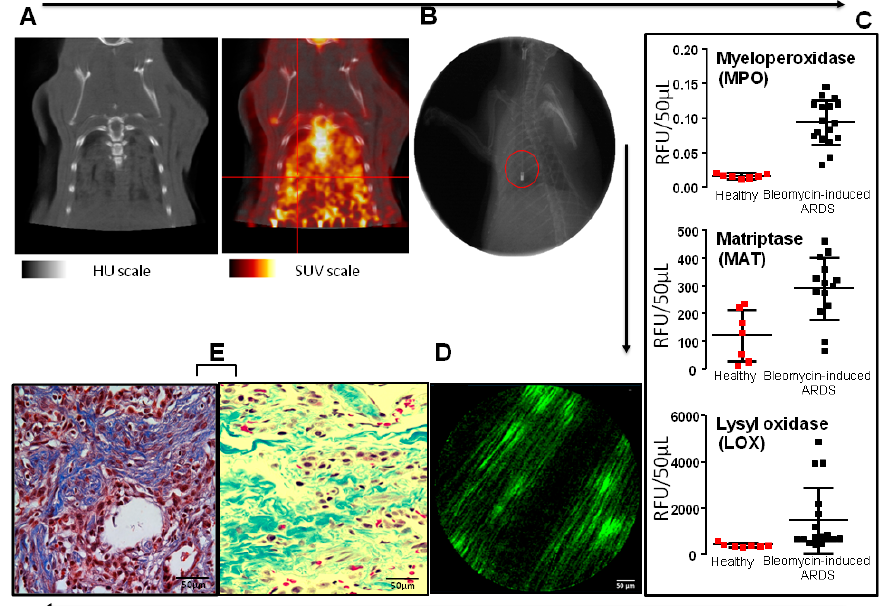
Figure 5. Proposed multimodality testing / imaging sequence in ARDS with unconventional timescale for recovery. Example of a preclinical approach with an experimental model of bleomycin lung in rat. ( A ) Acute lung injury with bilateral infiltrates is documented by PET–CT (respective scales: PET: 0 to 1.84 standardized uptake value (SUV); CT: − 1000 to + 2000 Hounsfield Units (HU)). Diffuse and enhanced uptake of fluoro-deoxyglucose (FDG) is documented allowing for the selection of a region-of-interest (ROI) for further investigations. ( B ) Endoscopy-guided exploration of a selected ROI (confirmed by X-ray fluoroscopy) is performed and a BAL is carried out. ( C ) Several enzymatic activities